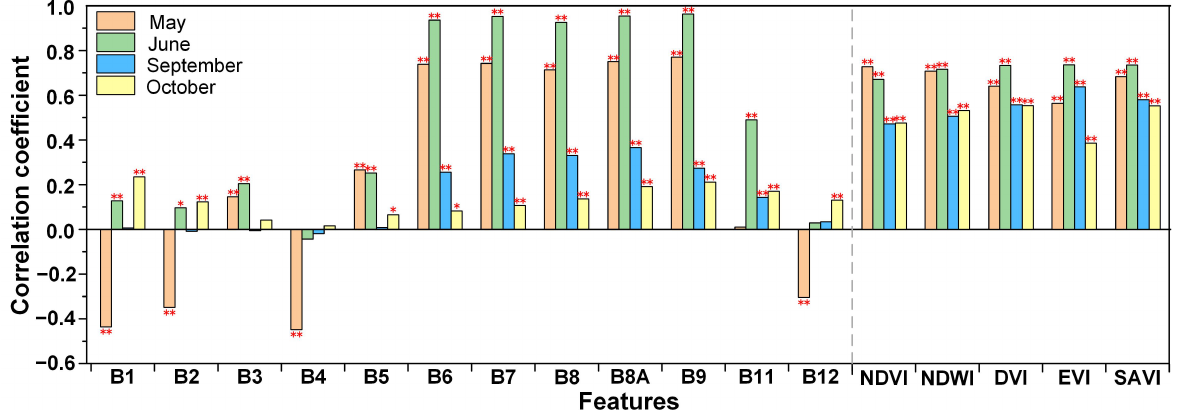
Figure 7. The correlation coefficient between predicted H ′ index and Sentinel-2 derived feature variables. **: Significant correlation ( p < 0.01), *: Significant correlation ( p < 0.05).